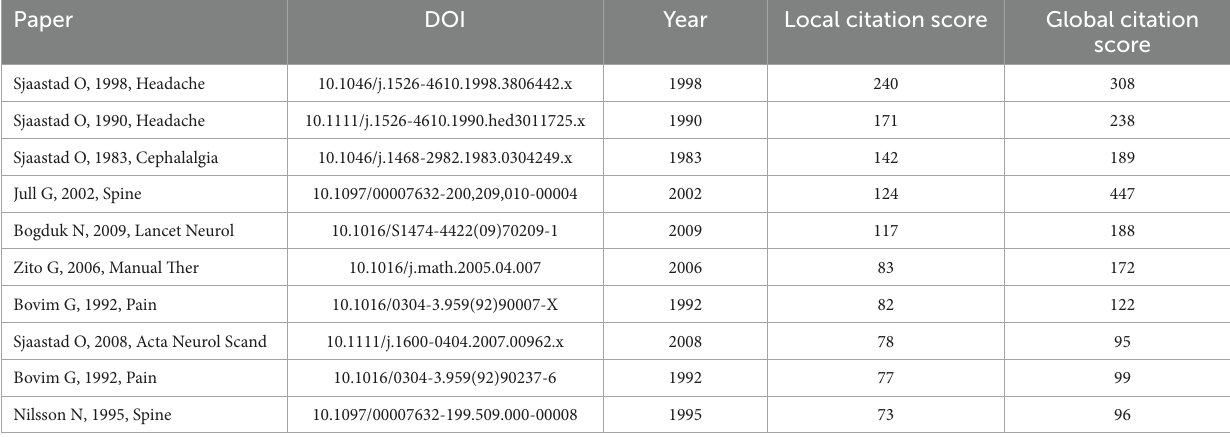
TABLE 5 Top 10 papers with the highest local citation score. Paper